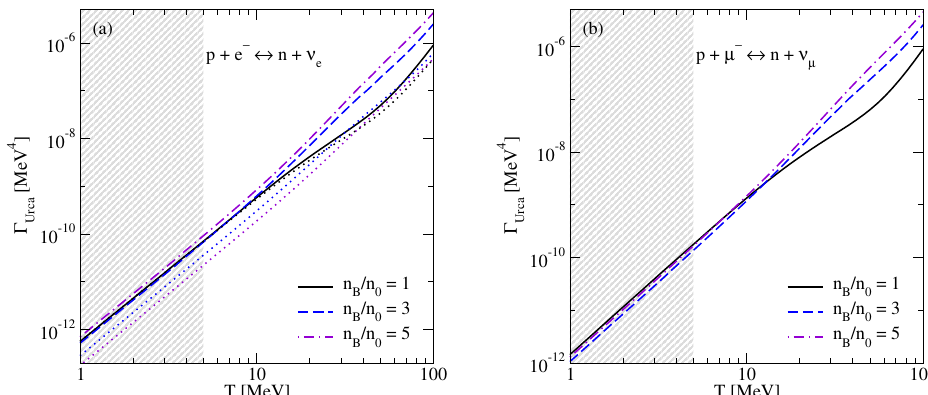
Figure 4. The electron ( a ) and muon ( b ) capture rates as functions of the temperature for various densities for the neutrino-trapped matter. The neutron decay rates are negligible compared to the lepton capture rates in the whole temperature-density range. The shaded areas show the neutrino transparent region of temperatures T ≤ 5 MeV. The dotted lines in panel ( a ) show the nonrelativistic approximation to the electron capture rates as computed in Ref. [18].